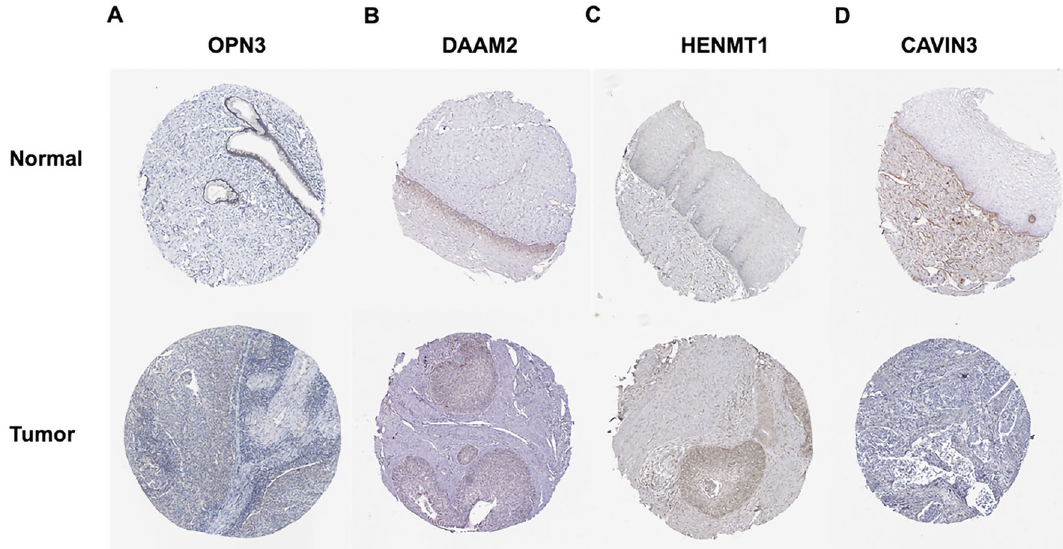
Figure 7. Representative immunohistochemical images of the 4 key mRNAs in CESC and adjacent normal tissues. The protein expression levels of OPN3 and HENMT1 were higher but the protein expression level of CAVIN3 was lower in CESC samples than those in normal samples (Human Protein Atlas).